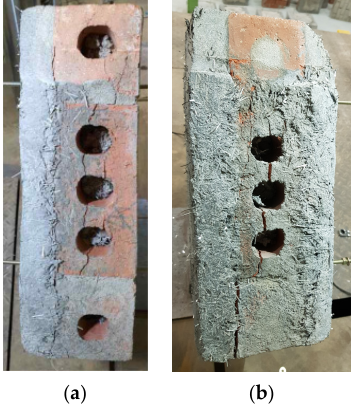
Figure 9. Damage state observed on lateral side after termination of diagonal tension tests: ( a ) D-SF-30S; ( b ) D-SF-30B.